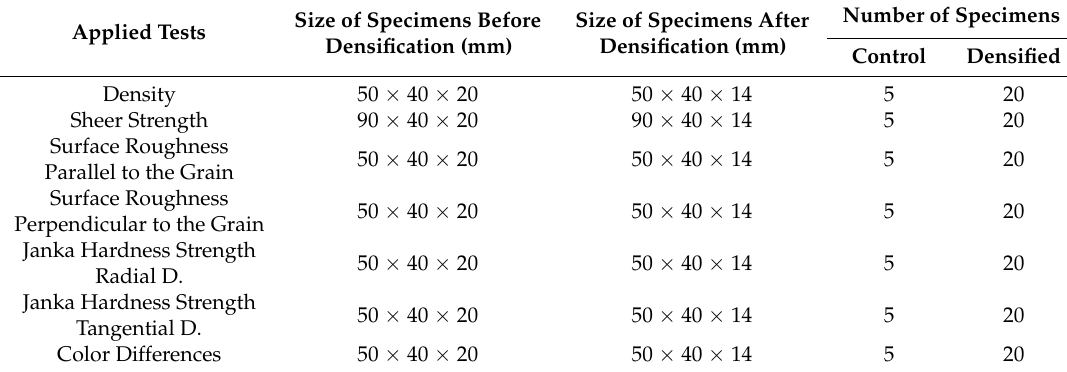
Table 1. Dimensions of the samples densified using heat and